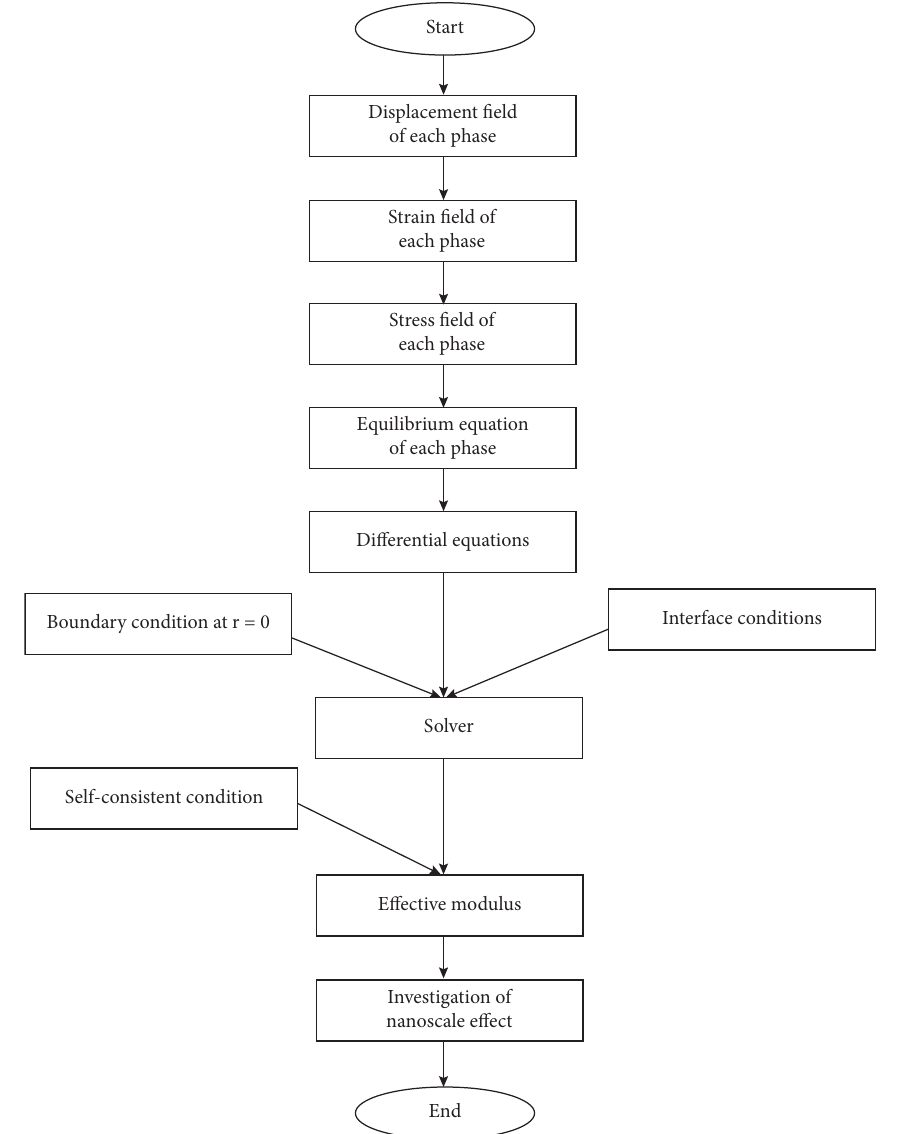
Figure 3: Flowchart methodology of this